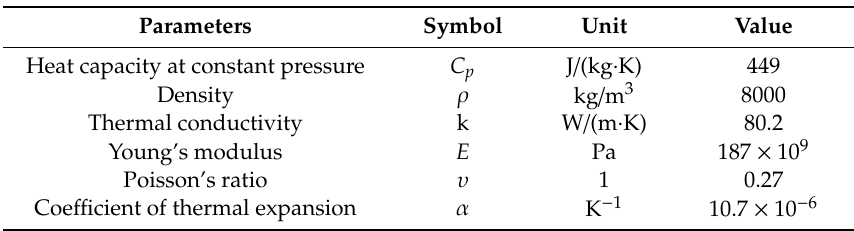
Table 1. Simulation parameters of the balance.